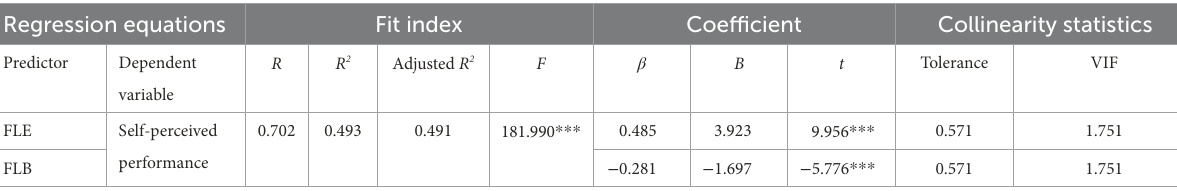
TABLE 9 Regression analysis with three emotions as predictors of self-perceived performance for speaking